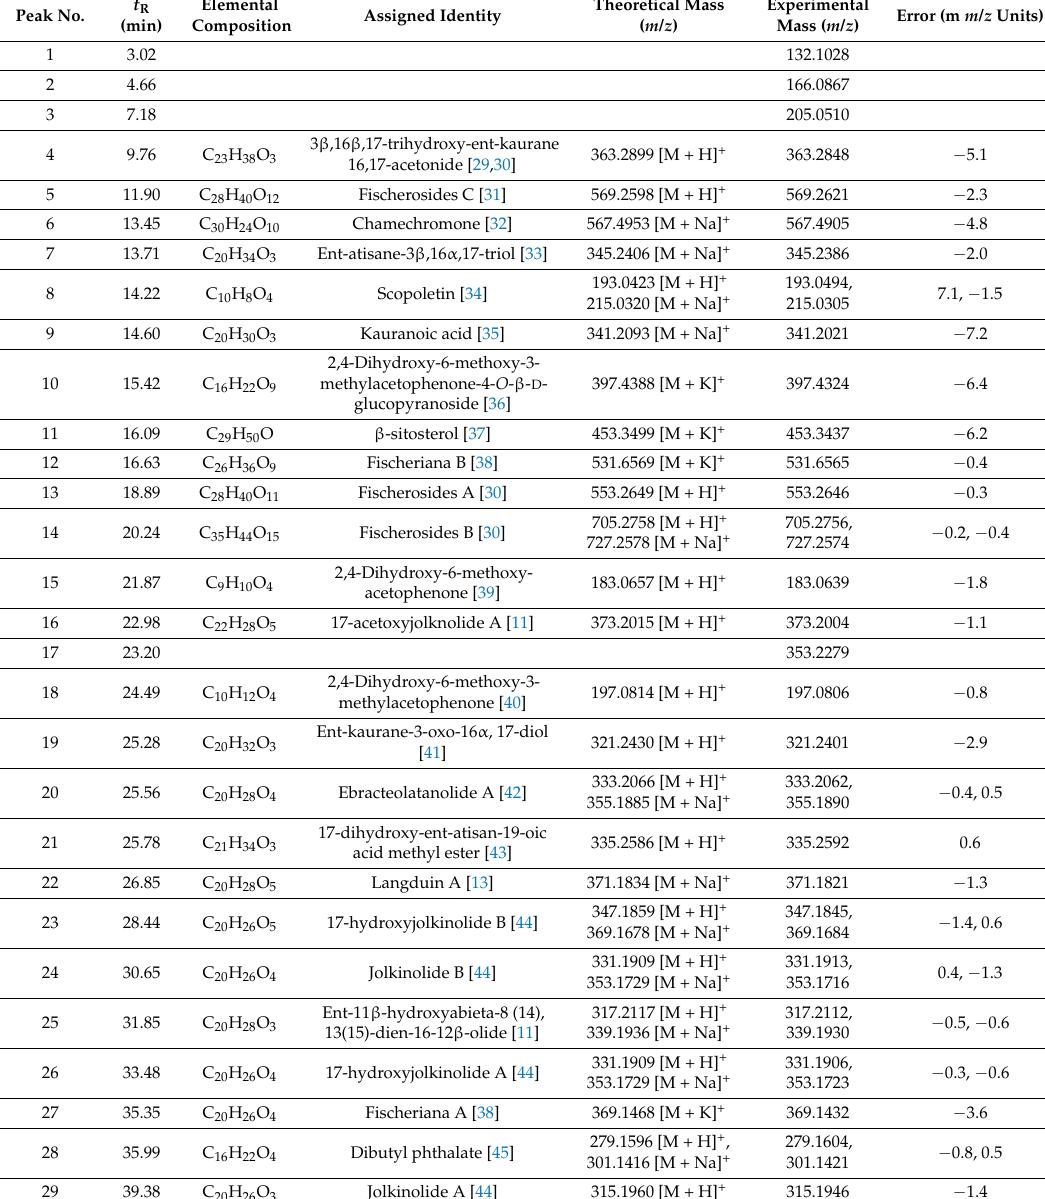
Table 2. Components of Euphorbia fischeriana identified by ultra-performance liquid chromatography coupled with the quadrupole time-of-flight tandem mass spectrometry (UPLC-Q-TOF-MS) in positive-ion